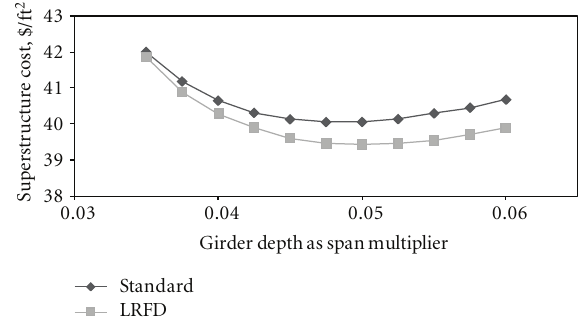
Figure 12: E ff ect of span-to-depth ratio on superstructure cost (150ft span, eight webs spaced at 10